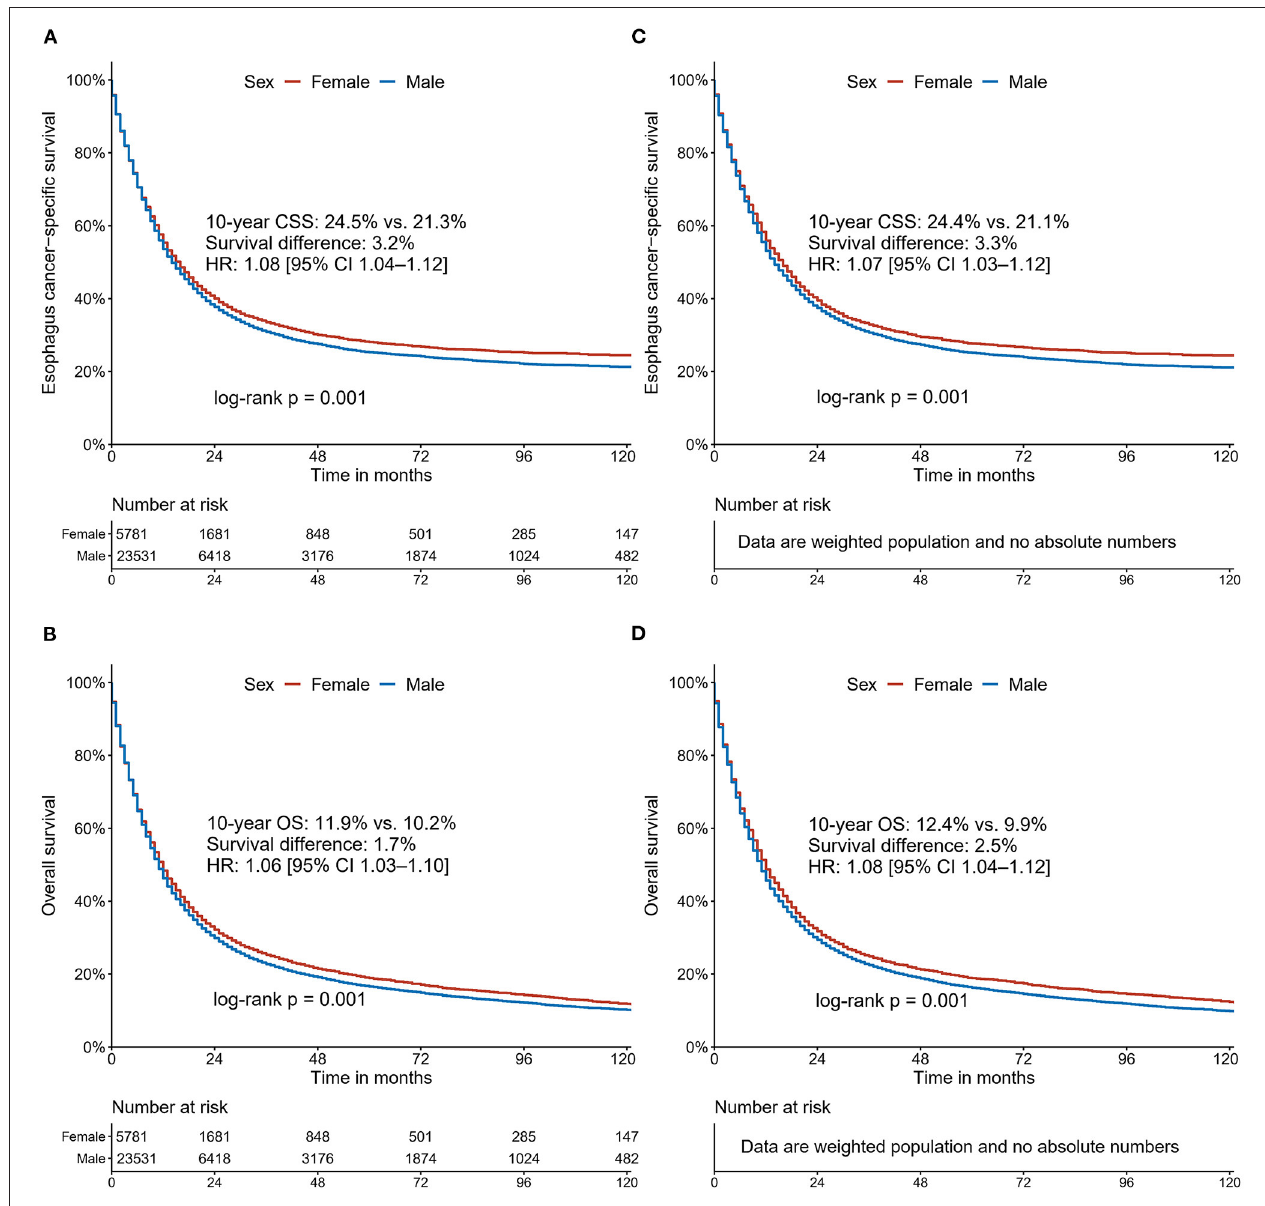
FIGURE 2 | Cancer-specific survival and overall survival curves stratified by sex for patients with esophageal cancer: unadjusted (A,B) ; Inverse Probability Weighting-adjusted (C,D)